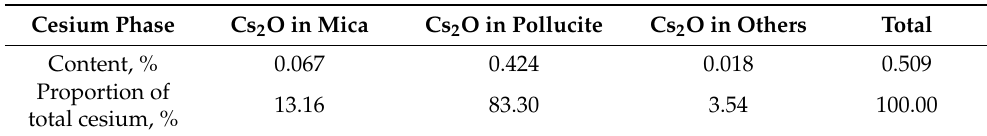
Table 4. Results of chemical cesium phase analysis.